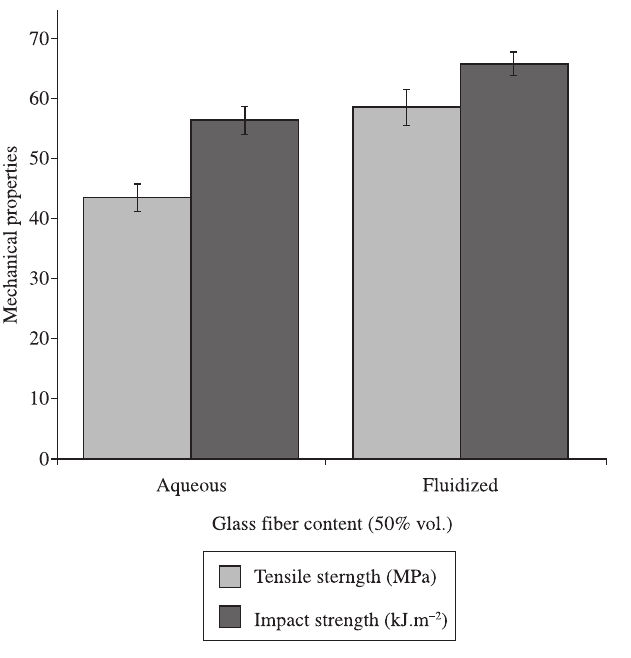
Figure 7. Tensile Strength and impact strength of the composites in relation to the manufacturing method of the hybrid mat (50% glass fiber / 50% sisal fiber).